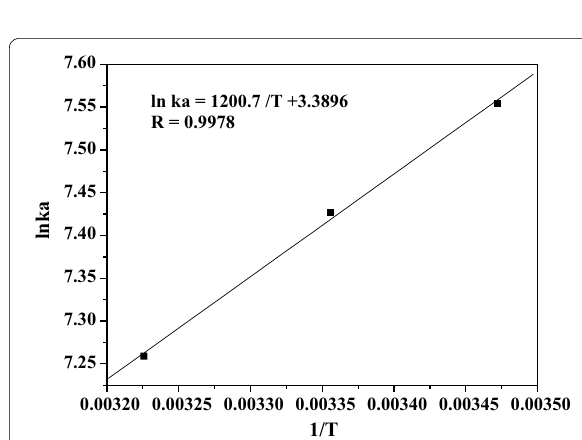
Fig. 5 Double logarithm plot of HSA paeoniflorin concentrations (from 0.0 at 2.5 10 − 6 mol L − 1 intervals) at three temperatures × ([HSA] 1.0 10 − 5 mol L − 1 ) = ×